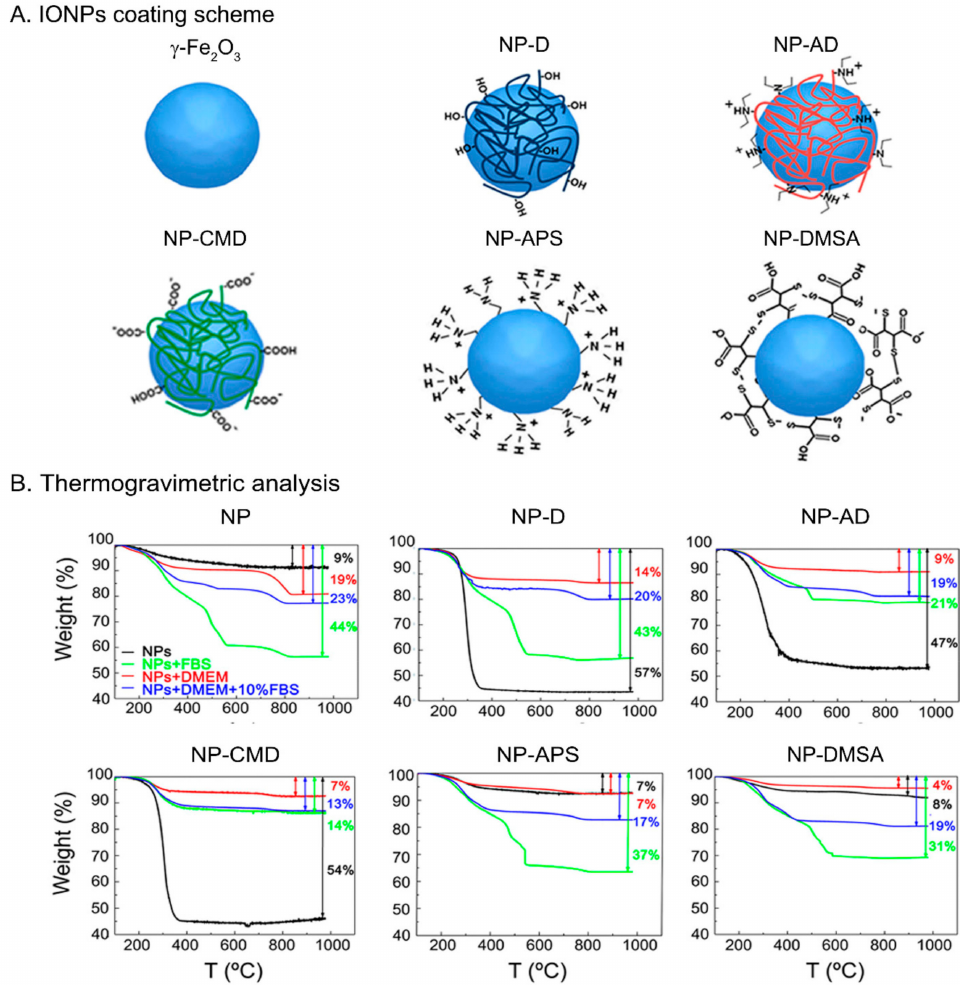
Figure 1. ( A ) Scheme illustrating the IONPs with the different coatings: NP ( γ -Fe 2 O 3 ), NP-D (dextran), NP-AD (amino-dextran), NP-CMD (carboxymethyl-dextran), NP-APS (aminopropyl- trietoxy silane), NP-DMSA (dimercaptosuccinic acid). ( B ) TGA measurements of IONPs suspended in different media, water (black), FBS (green), DMEM (red), and DMEM (10% FBS)